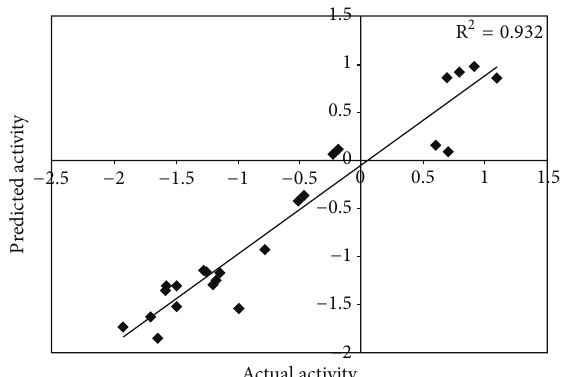
Figure 4: Plot of actual versus predicted values for the test set molecules with the help of MLR statistical method.